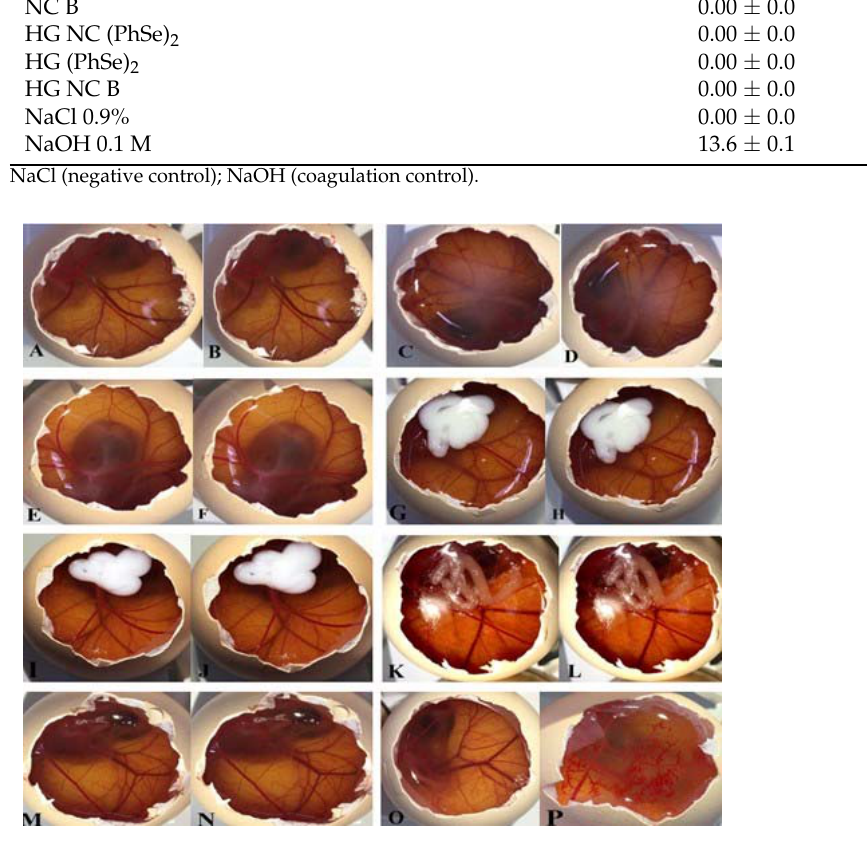
Figure 5. Images of the chorioallantoic membrane test demonstrating CAM exposed when the formulations were applied (time zero) and 5 min v application: ( A , B ) PhSe 2 ; ( C , D ) NC PhSe 2 ; ( E , F ) NC B; ( G , H ) HG NC PhSe 2 ; ( I , J ) HG NC B; ( K , L ) HG PhSe 2 ; ( M , N ) Locust bean gum HG (vehicle); ( O , P ) negative (0.9% NaCl) and positive control (0.1 M NaOH), respectively.